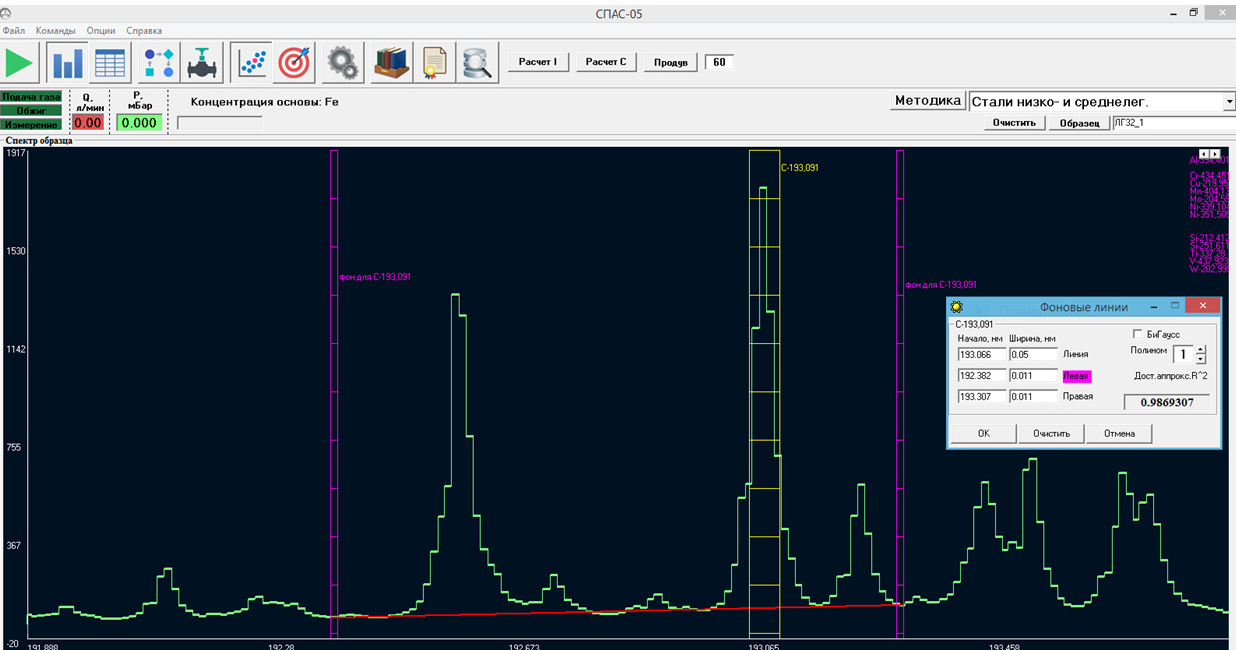
Figure 1. The software window of SPAS-02 emission spectrometer (in Russian); yellow marks the pixels of which the signal must be summed when calculating the C 193 nm analytical-line intensity; purple marks the reference frames for background calculations; in this case, the background shape was chosen to be linear (the red line).